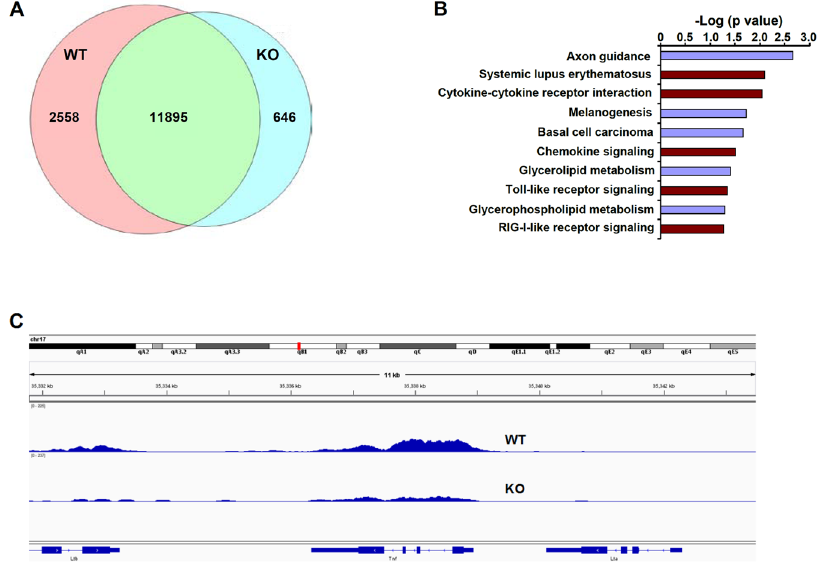
Figure 6. MKL1 influences global H3K4Me3 levels in BMDMs. Wild type (WT) or MKL1 deficient (KO) BMDMs were treated with TNF- α (10 ng/ml) for 3 hours. ChIP was performed with anti-H3K4Me3. ( A ) Venn diagram illustrating the overlap of binding peaks identified in WT and KO BMBM ChIP-seq data sets. ( B ) Pathway analysis of significantly enriched H3K4Me3 tags found within ± 2 kb relative to the TSS of the nearest gene. ( C ) Graphical view of H3K4Me3 ChIP-seq binding peaks (tag densities) around the TSS of TNF- α